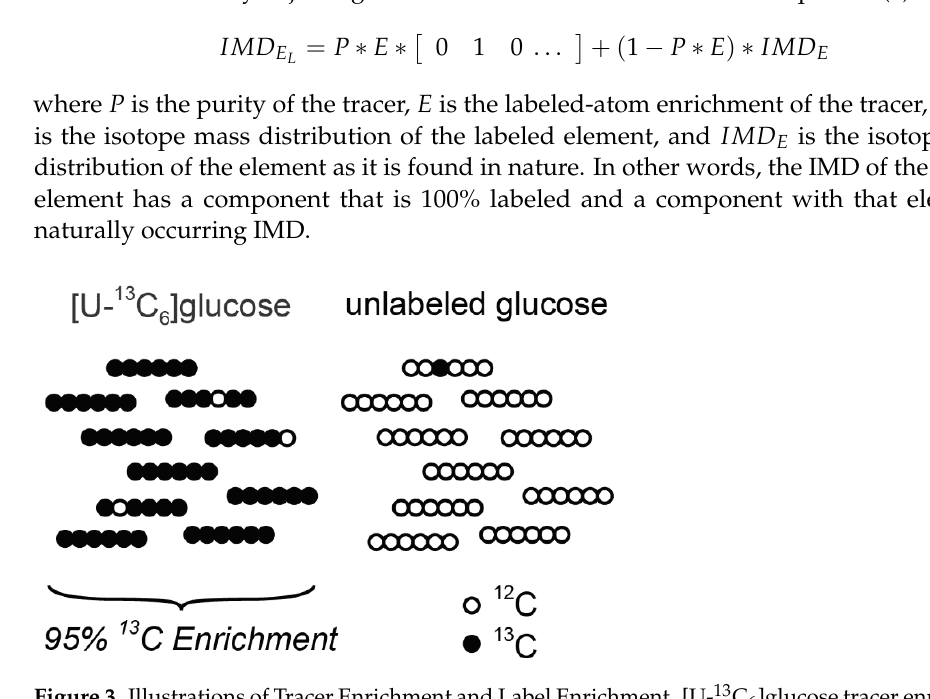
Figure 3. Illustrations of Tracer Enrichment and Label Enrichment. [U- 13 C 6 ]glucose tracer enrichment is 50 % and 13 C label enrichment is 95 %.